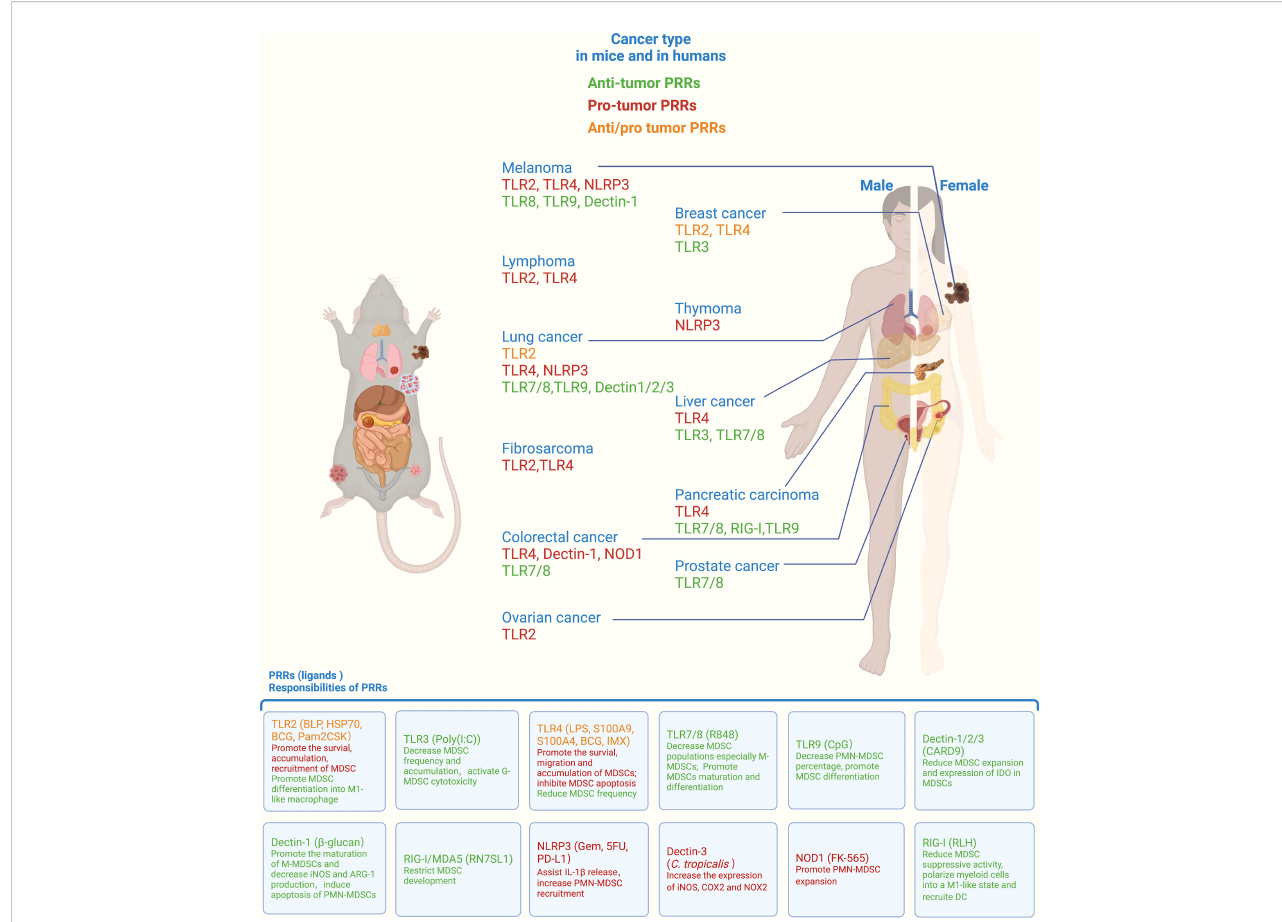
FIGURE 1 Roles of PRRs in orchestrating myeloid-derived suppressor cell (MDSC) function across different cancers. PRRs represent the primary MDSC receptors for integrating signals from pathogens or damaged cells. By recognizing different ligands, PRRs orchestrate MDSC immunosuppressive function, survival, migration, accumulation, differentiation, and soluble molecule release, thus exerting protumor or antitumor effects in mice and humans. PRRs, pattern recognition receptors; TLR, Toll-like receptor; NLRP3, NLR family pyrin domain containing 3; NOD1, nucleotide oligomerization domain; RIG-I, retinoic acid-inducible gene-I; BLP, bacterial lipoprotein; HSP70, heat shock protein 70; BCG, Bacille – Calmette – Guer ı ́ n; LPS, lipopolysaccharide; S100A9, S100 calcium-binding protein A9; CARD9, caspase activation and recruitment domain 9; Gem, gemcitabine; 5FU, 5- fl uorouracil; PD-L1, programmed death- ligand 1; RLH, RIG-I-like helicases. All listed PRRs were demonstrated to regulate MDSC function in mice, whereas only the PRRs indicated with lines were proven to modulate MDSC function in human cancers. The role of ALRs is not shown above due to the lack of relevant